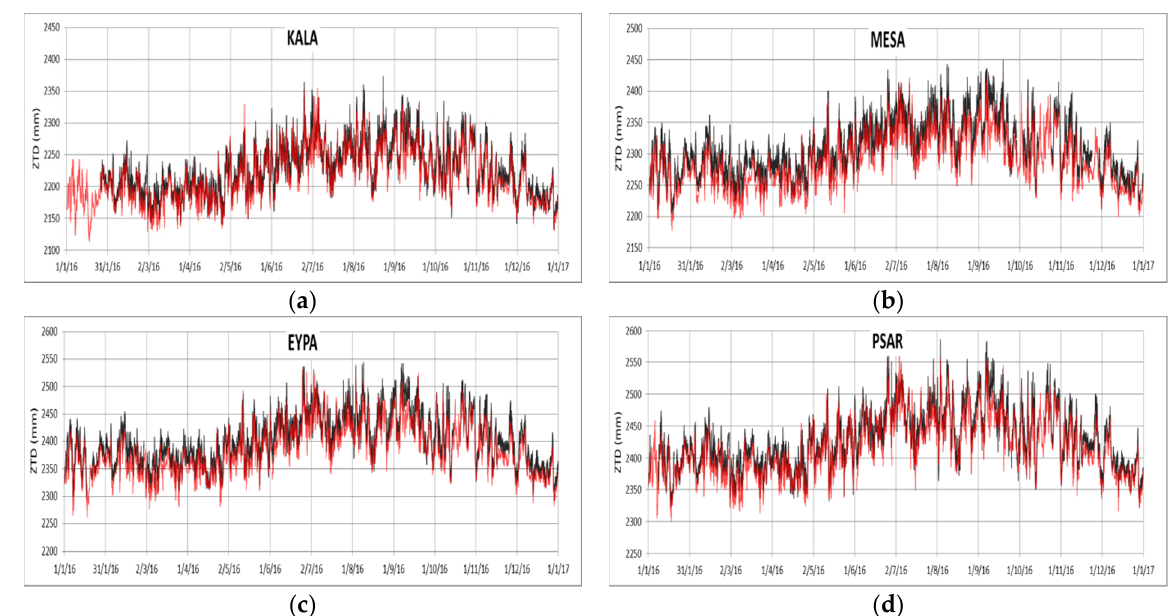
Figure 7. Observed and simulated time series of WRF MOD5 vs. GNSS ZTDs at 4 PaTrop stations, KALA ( a ), MESA ( b ), EYPA ( c ) and PSAR ( d ) over January–December 2016.